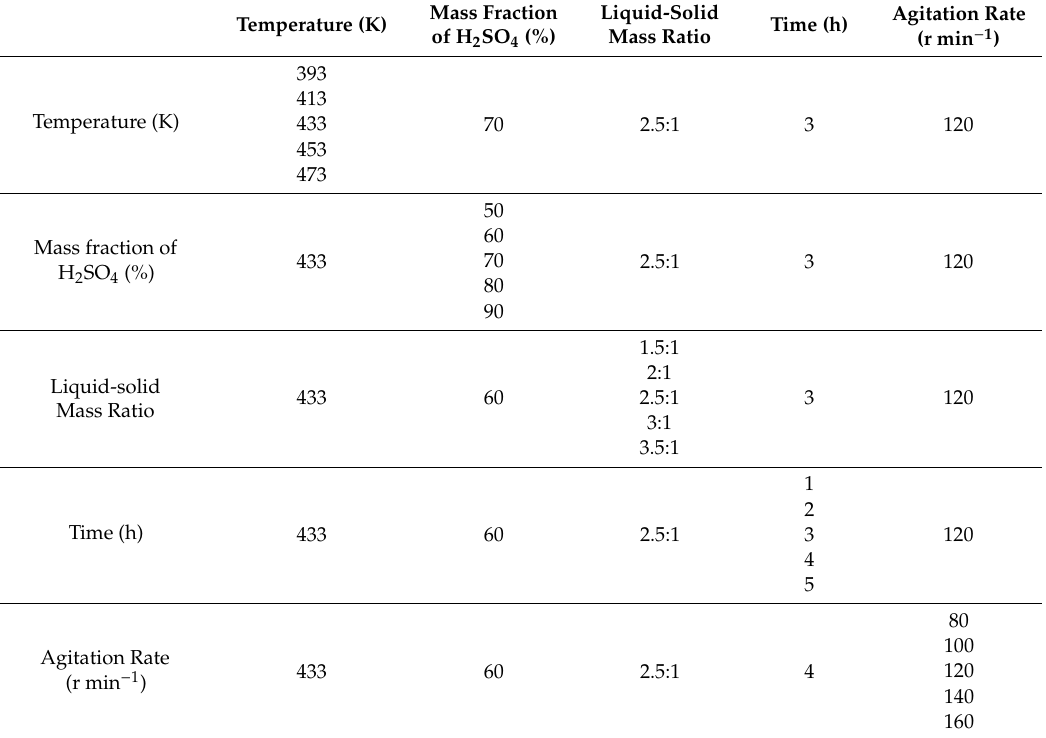
Table 3. Experimental conditions for leaching lepidolite with sulfuric